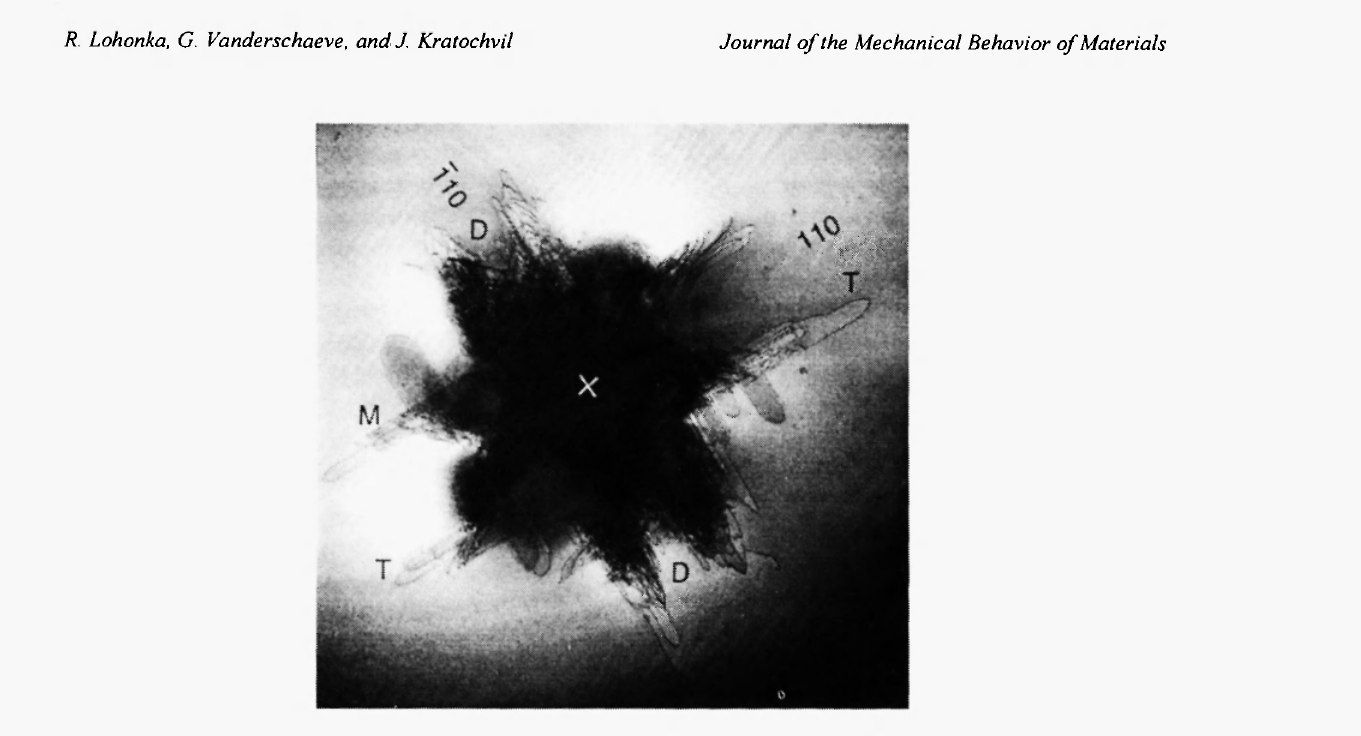
Fig. 1: High Voltage (1MV) TEM image of the plastic zone around an indent performed on GaAs. Bright field micrograph, magnification 7500. The indentation point is marked by cross. Τ — rosette perfect dislocations, Μ — microtwins, D — dislocations in the diverging slip planes. Courtesy according to